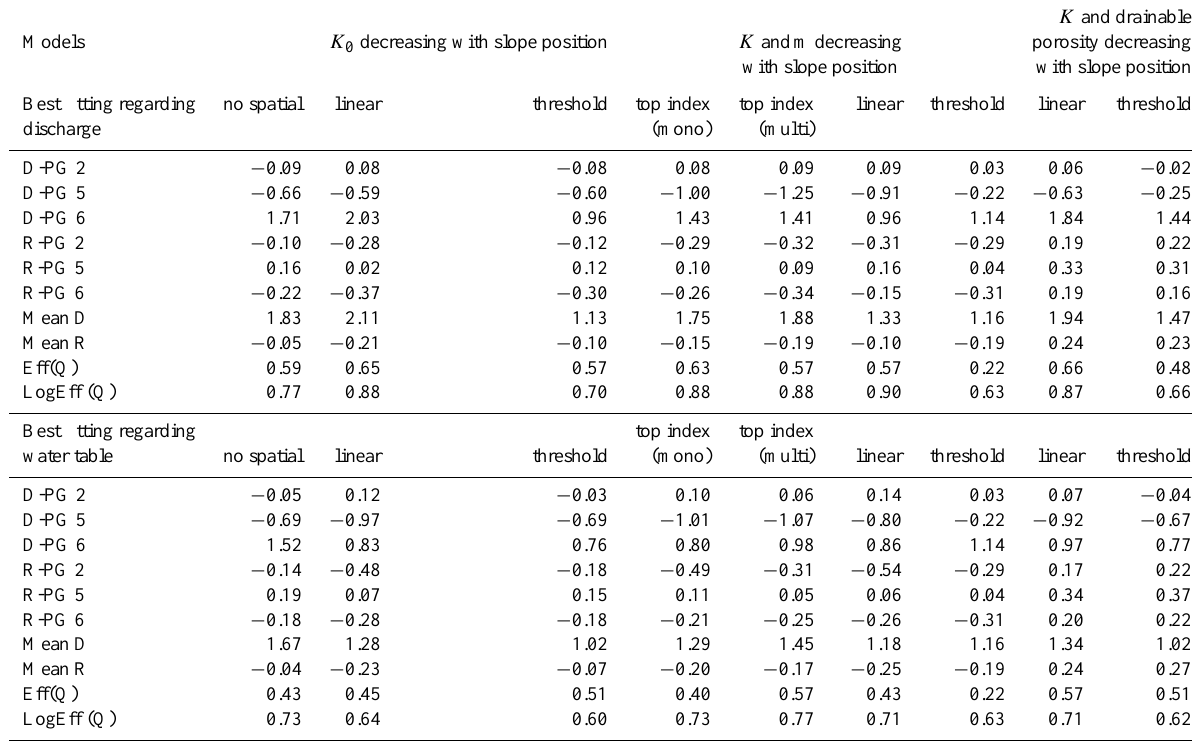
Table 3. Mean error ( D ) and log of the relative range of variation ( R ) of water table depth during the testing period for three wells – PG2 (bottom), PG5 (midslope) and PG6 (plateau) – and their average values (Mean D and Mean R ), as well as discharge efficiency and Log discharge efficiency, with different spatial models of variation in physical